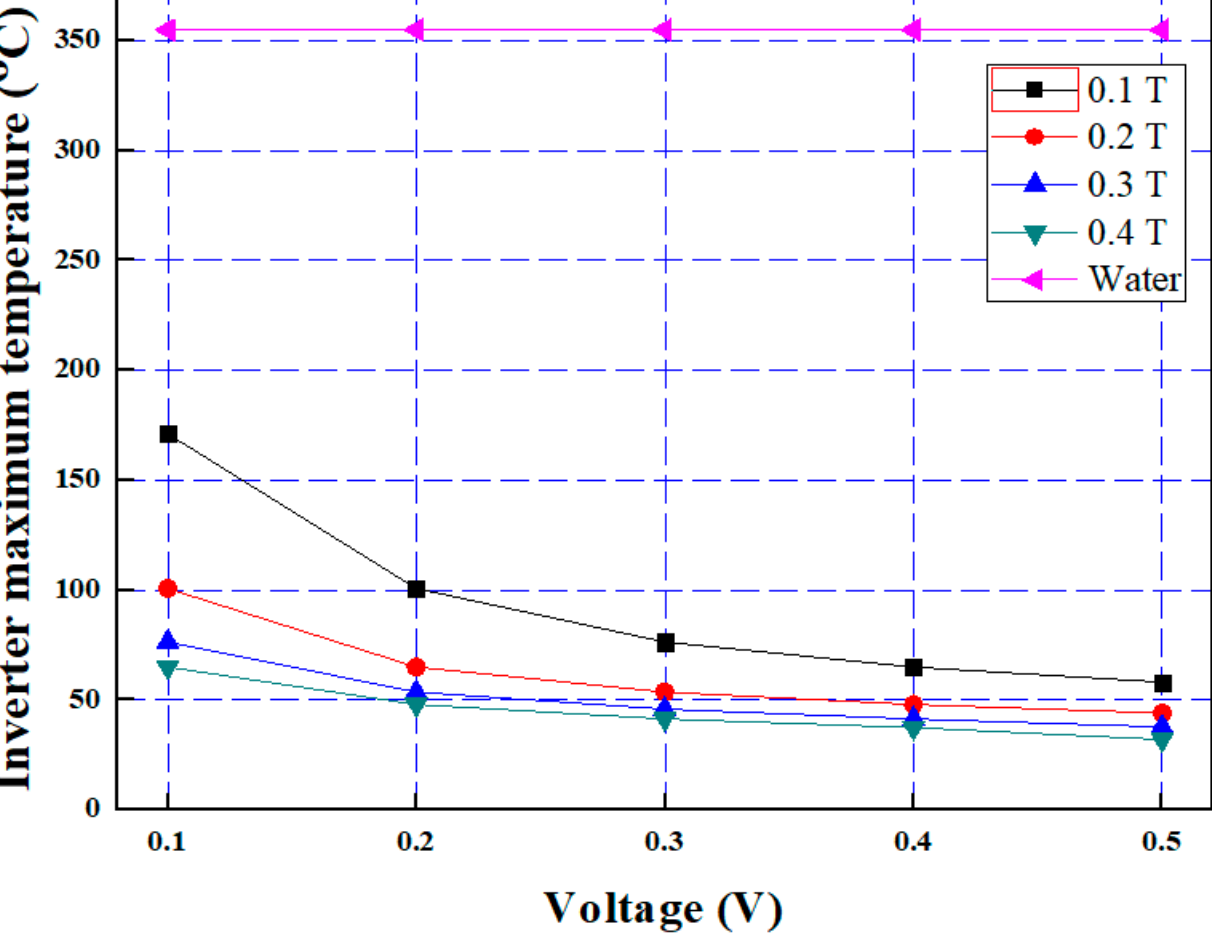
Figure 11. Inverter maximum temperature for water and ferrofluid cooling under various conditions of electromagnetic parameters.